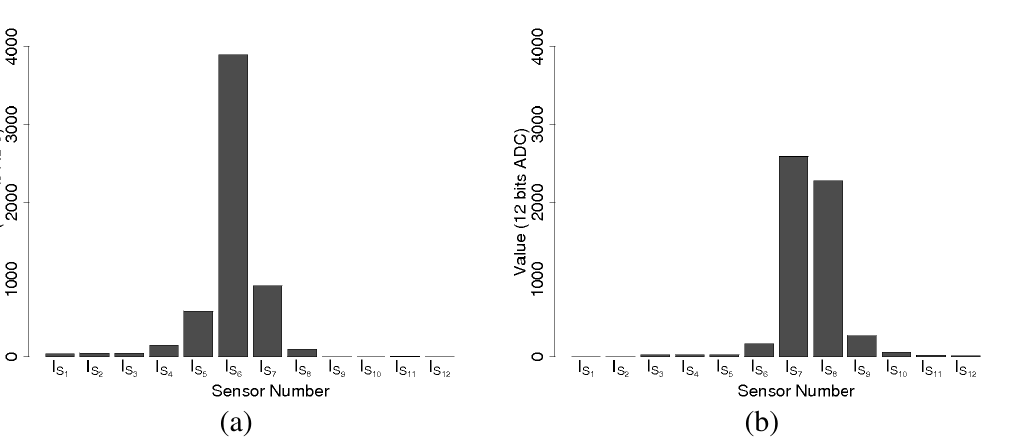
Figure 10. Sensory map for two different reception frames. (a) The emitter is approximately facing a reception sensor. (b) The emitter is in some point in between two reception